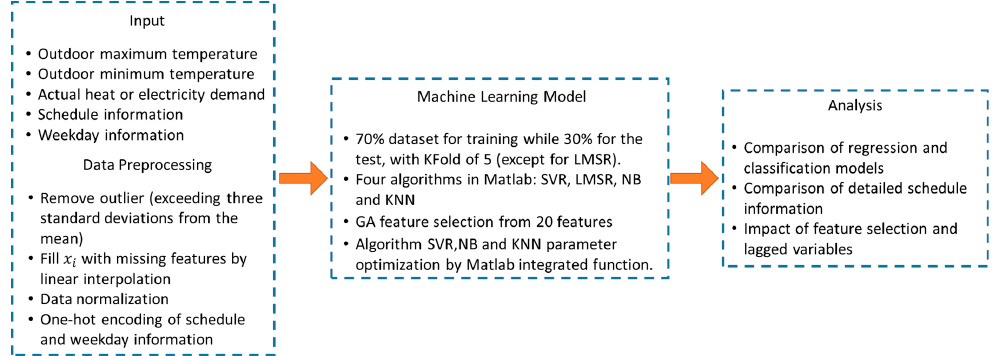
Figure 1. Schematic diagram describing structure of training data.